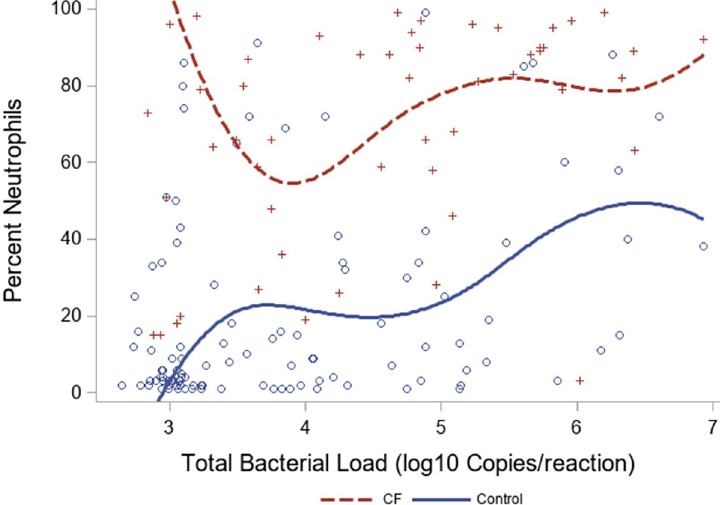
Fig 4. Neutrophilic inflammation. Percent neutrophils across the spectrum of bacterial burden. Notable differences are seen between CF and DC subjects. While CF subjects have heightened percent neutrophils regardless of load, DCs exhibit a stronger linear relationship between percent neutrophils and bacterial